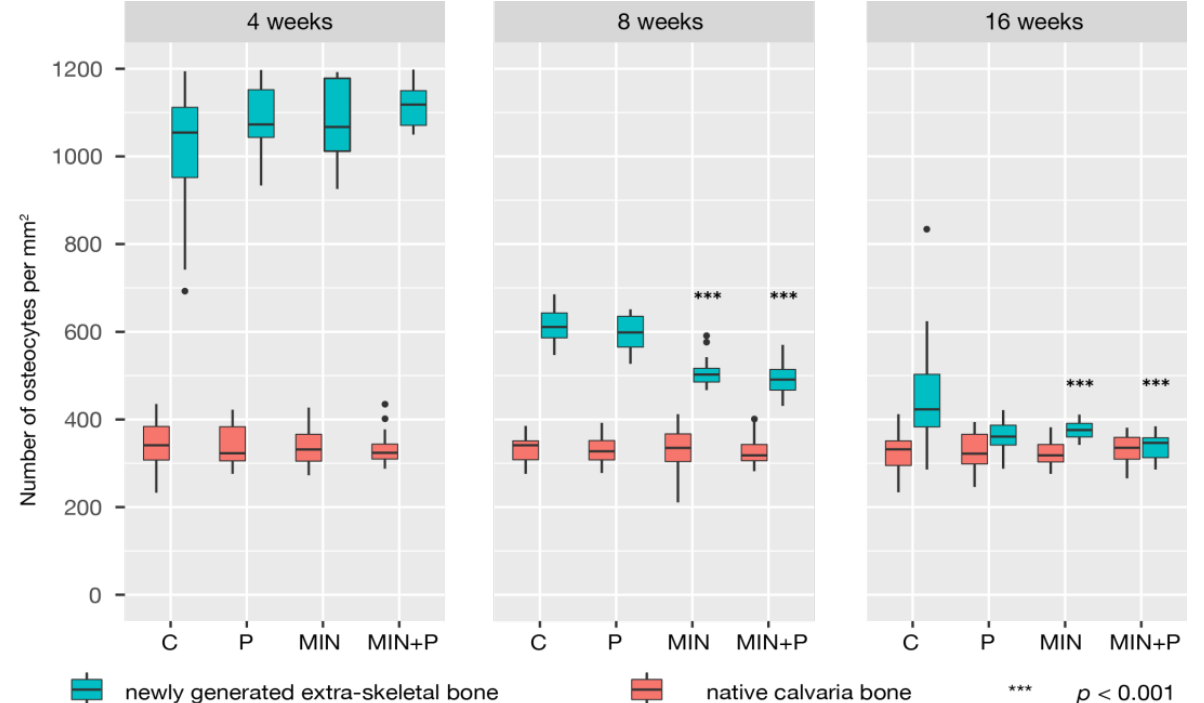
Figure 7. Density of osteocytes in native and newly generated bone. Woven bone contains many more osteocytes than lamellar bone, and the osteocyte density in the newly generated bone (cell number per unit section area of bone—expressed as Oc per mm 2 ) fell with its maturation. Notably, minocycline-treated specimens showed fewer osteocytes at 8 weeks than the control and perforated groups.